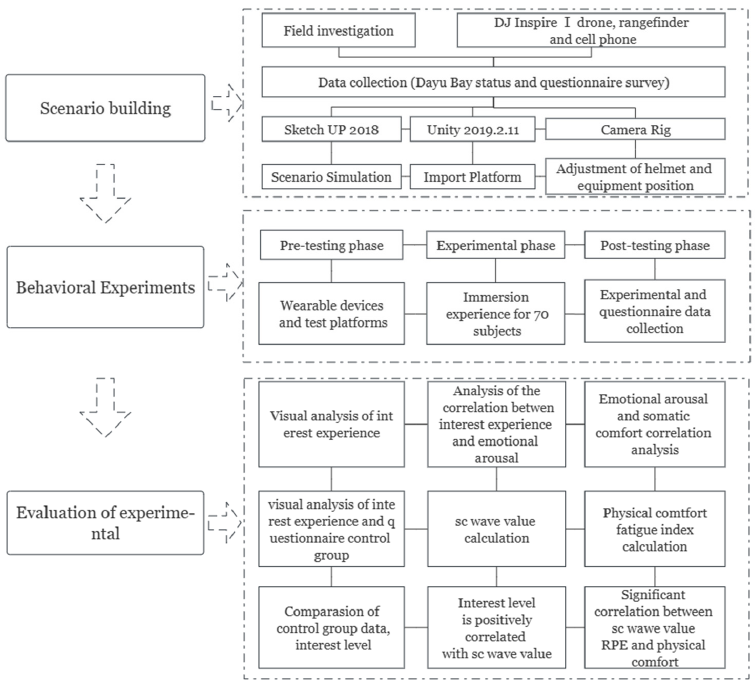
Figure 7. Mind map of innovation model. Source: Process on software production.